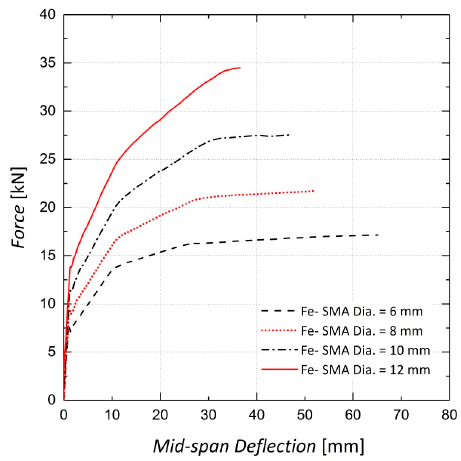
Figure 19. Sensitivity of results to Fe-SMA bar diameter—Beam 10.